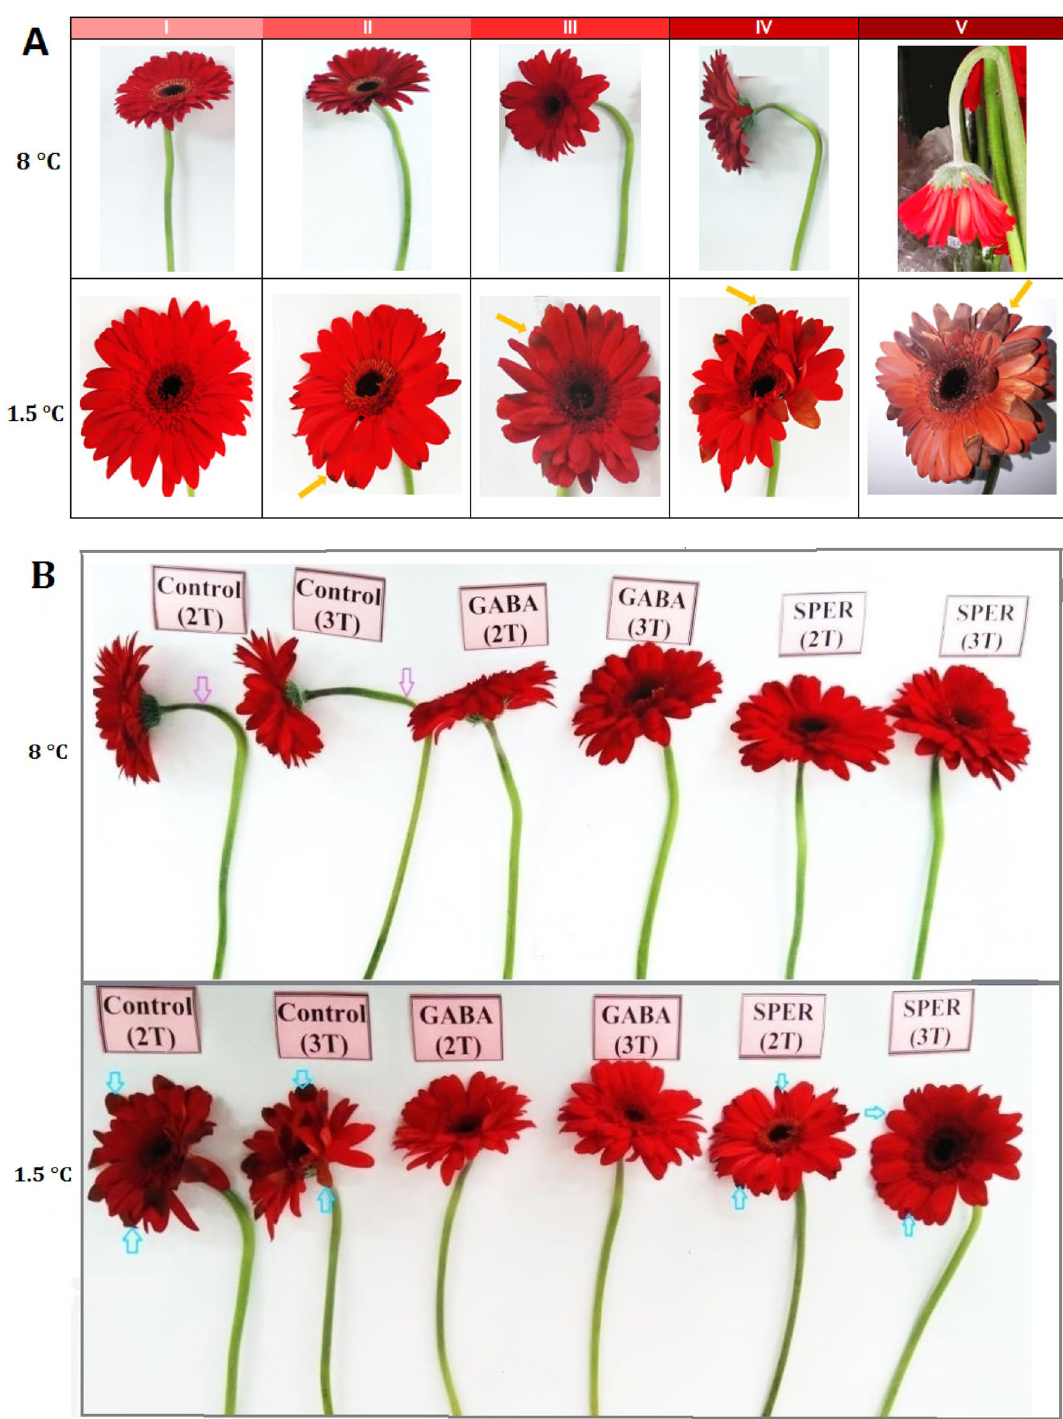
Figure 2. Schematic descriptor of the neck bending (Stage I-V) and chilling injury (CI) in gerbera ‘Stanza’ cut flowers during cold storage at 1.5 °C and 8 °C. I = no CI; II = mild CI (up to 10% chilling of capitulum); III = moderate CI (up to 30% chilling of capitulum); IV = severe CI (up to 50% chilling of capitulum); V = very severe CI (70–100% chilling of capitulum) ( A ). Effects of pre-harvest GABA and SPER treatments on the neck bending and chilling injury of the gerbera ‘Stanza’ cut flowers during cold storage at 1.5 °C and 8 °C, 15 days postharvest (dph) ( B